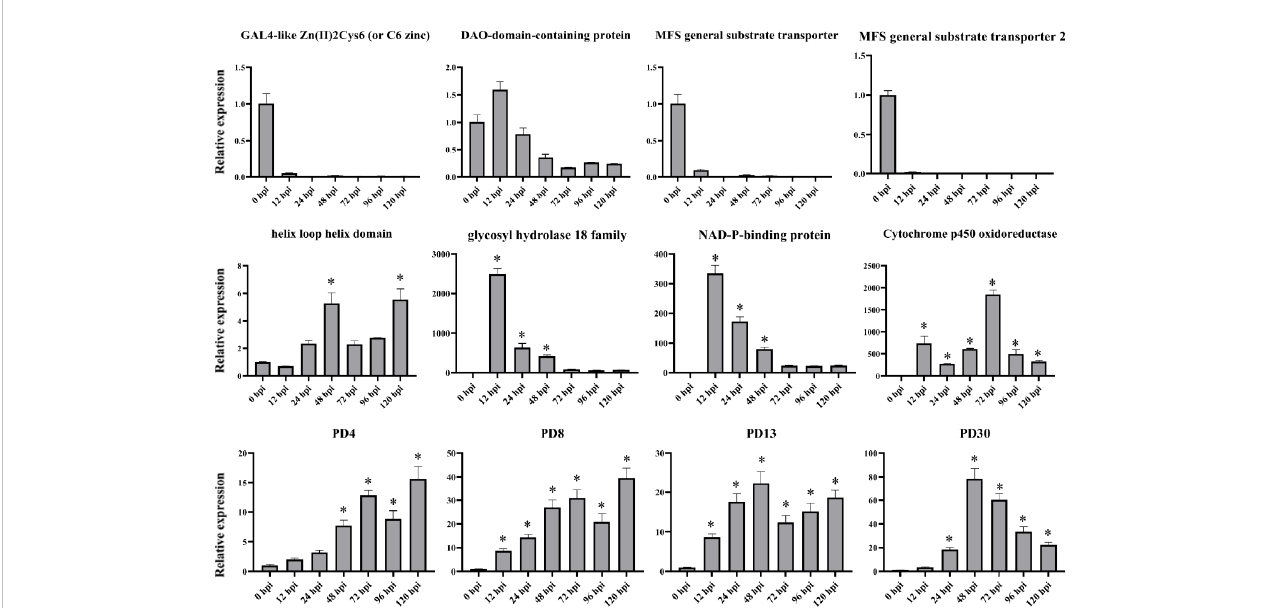
FIGURE 8 qPCR expression analyses of select genes at various time points post inoculation. X-axis: 12 – 120 h: R. solani – inoculated tobacco harvested at various time points. Y-axis: Relative expression levels of select genes in R. solani grown in PDA. Error bars indicate the mean of three biological replicates. Asterisk (*) represents signi fi cant difference (P <